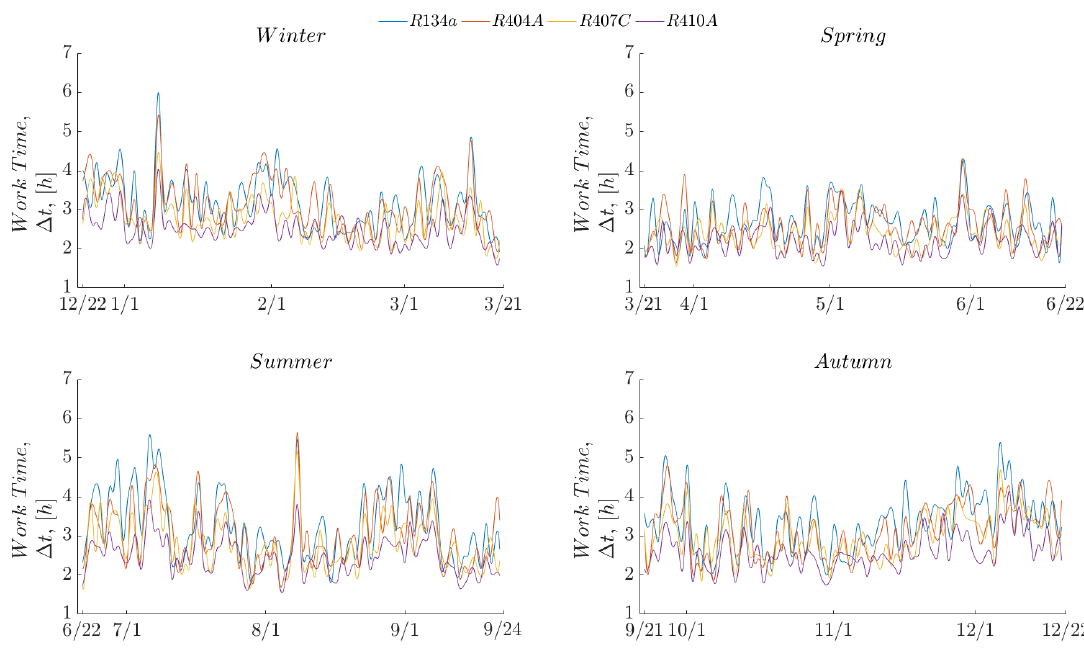
Figure 18. Work time optimization for all refrigerants.